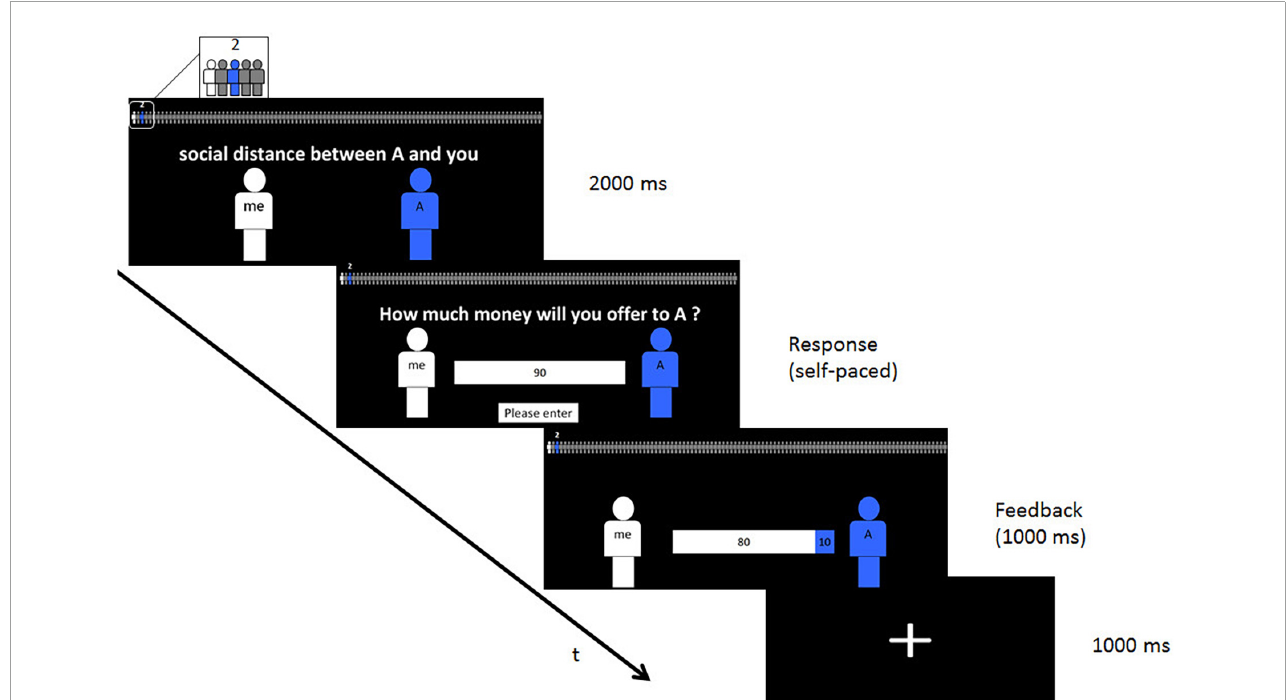
FIGURE1 Experimental design. After a fixation cross, a social distance line was displayed across the top of the screen showing a white and a blue person, respectively, representing the participant and the receiver. The number above the blue icon indicated their exact social distance to the participant. Then, participants were shown one of 5 possible endowments (€80, €90, €100, €110, €120 for French, or the same amount in Yuan for Chinese subjects). Participants had to type on a keyboard the exact amount that they were willing to send to the recipient (here €10). A feedback screen indicated the amounts for the participant (here €80), and the receiver (here